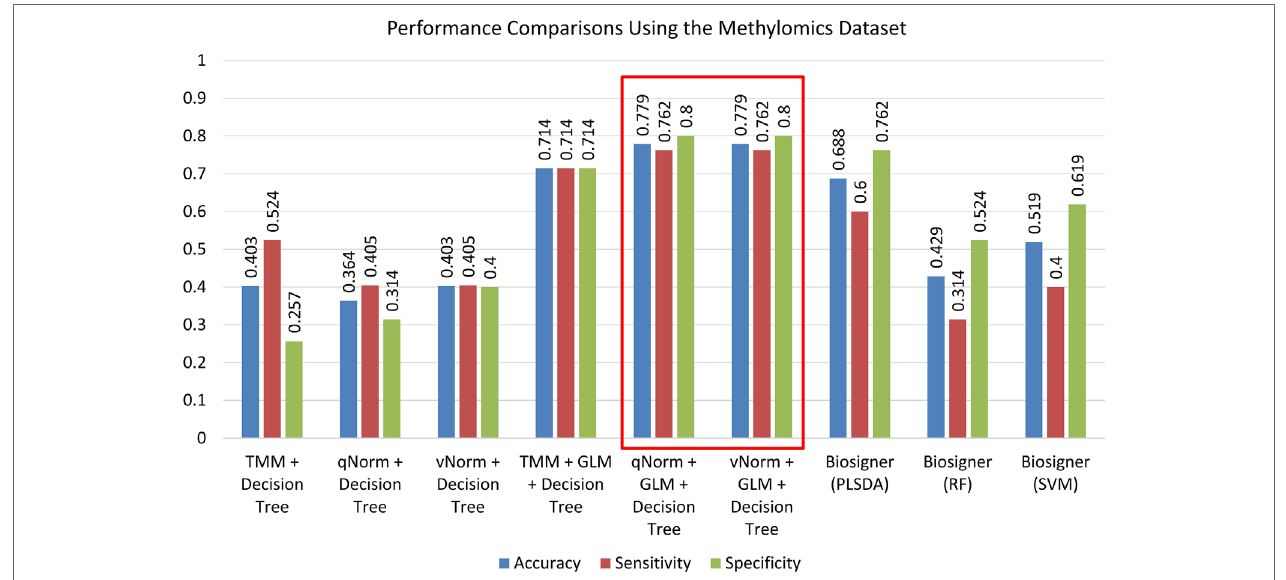
FIGURE 7 | Performance comparisons using the methylomics